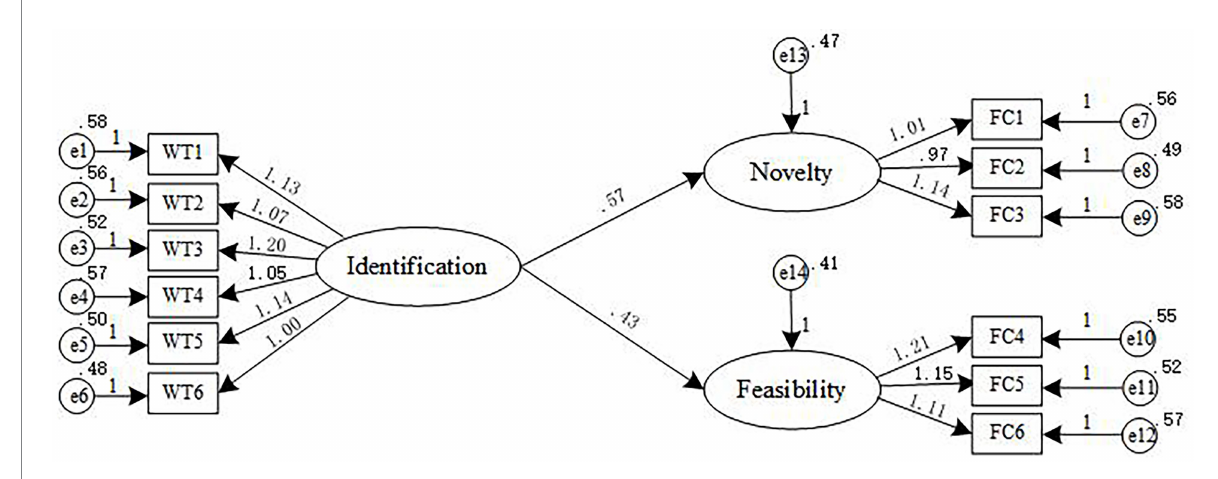
FIGURE 2 Relationship between identification and the creativity of family businesses.